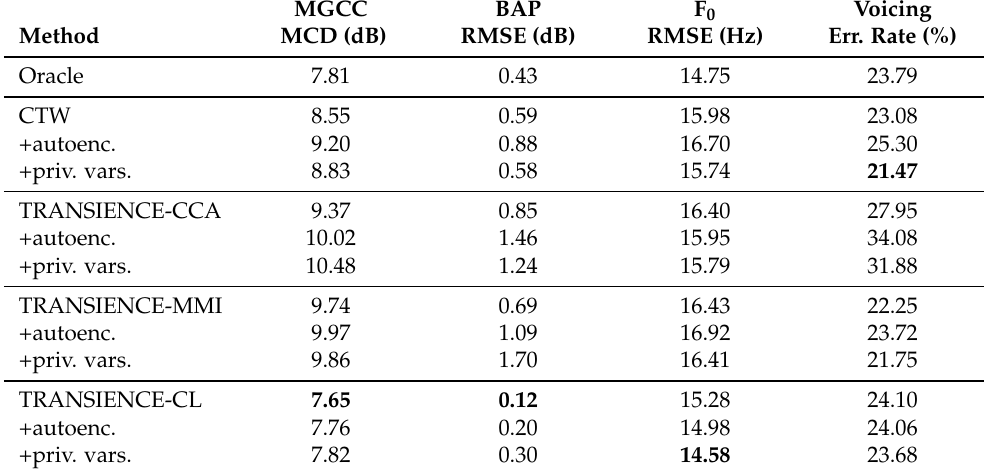
Table 2. Summary of the objective results obtained by each alignment technique on an A2A task where speech was synthesized from PMA data captured from the lips and tongue using